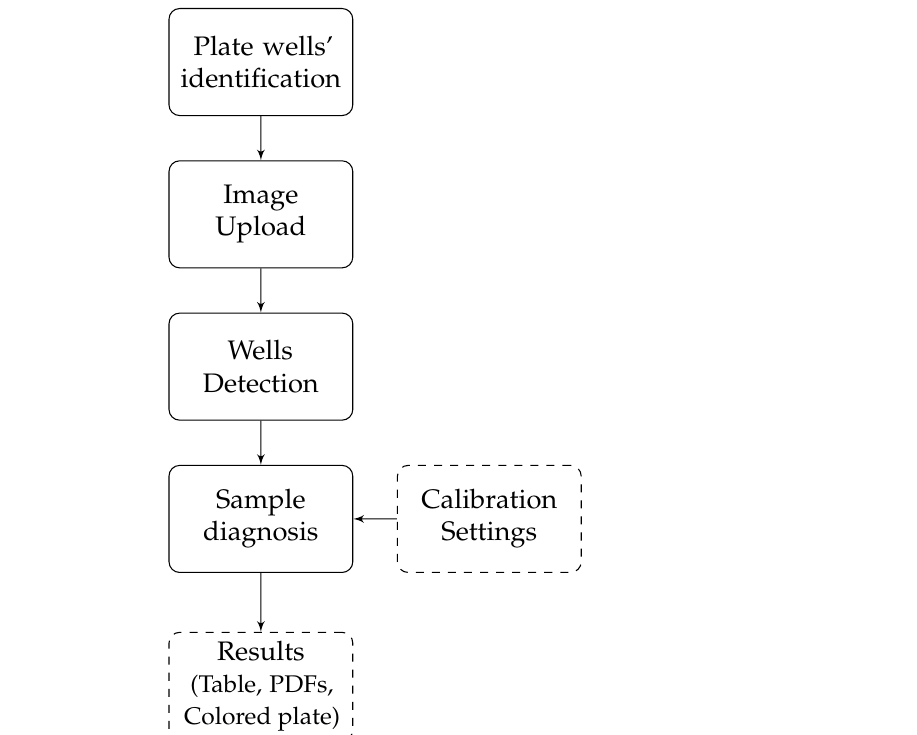
Figure 10. Setup step in the ELISA Plate Analyzer software. used. A scanner is preferable because it reduces variability sources like shadows or low 197 manual steadiness. Preliminary tests with smartphone cameras resulted in images with 198 heterogeneous quality, presenting shadows in the wells furthest from the center of the 199 plate.